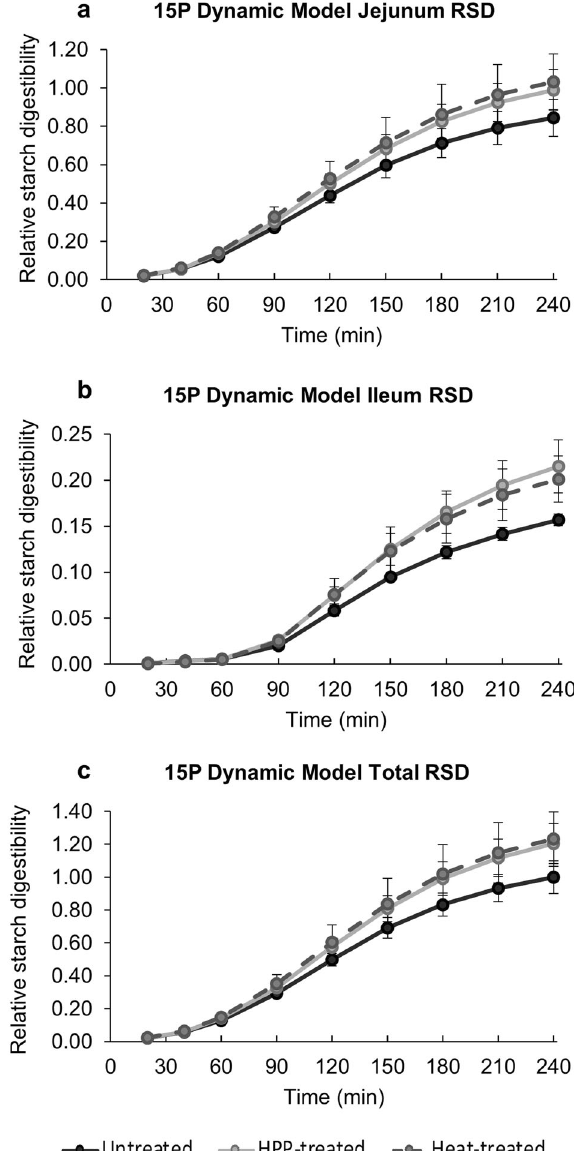
Fig. 6 Average cumulative relative starch digestibility (RSD) over time for dynamic digestions of pea protein concentrate with 15% (w/w) protein (15 P). The average cumulative RSD (unitless) for a 15 P digesta of the jejunum, b 15 P digesta of the ileum, and c 15 P total (jejunum + ileum) digesta was calculated with respect to the average cumulative RSD of 15 P DCT 240,Untreated (average % digested starch/average % digested starch of DCT 240,Untreated ). DCT 240,Untreated is the dynamic model cumulative total (jejunal + ileal) digesta for untreated samples after the full 240 min digestion, see Table 1 for all symbol descriptions. The glucose assay was performed on each independent replicate of digestions in technical duplicate, where the % digested starch for each independent digestion was an average of the technical duplicates. Points represent the average cumulative RSD for the three independent digestions. Error bars display the standard deviation. Statistical analysis of the effect of treatment type on digestibility was performed at each time point of the jejunum, ileum, and total (jejunum + ileum) digestion. No statistical comparisons were signi fi cant ( p >